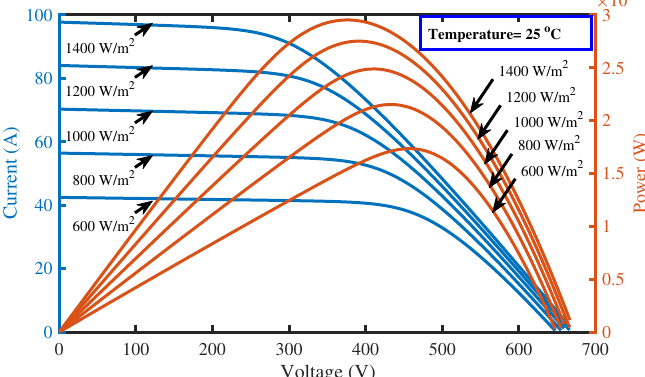
Figure 6. I-V and P-V characteristics for varying